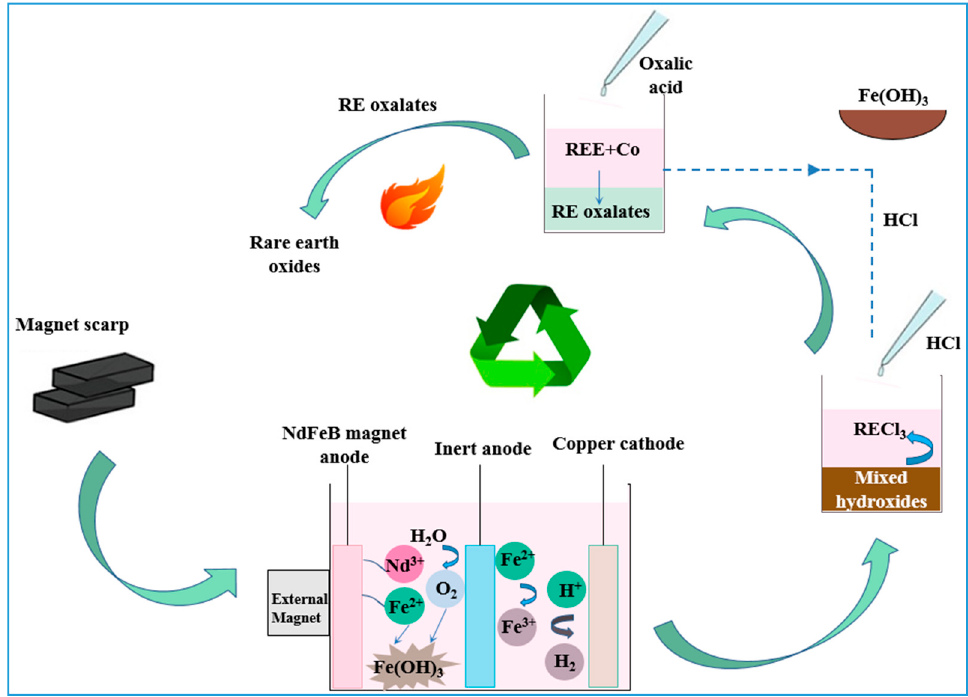
Figure 10. Process flowsheet for the proposed recycling scheme [79]; published by American Chemical Society, 2018